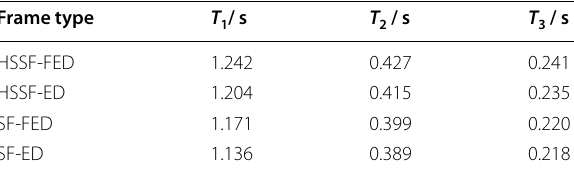
T 1 , T 2 and T 3 are the 1 st , 2 nd and 3 rd fundamental period of the frames